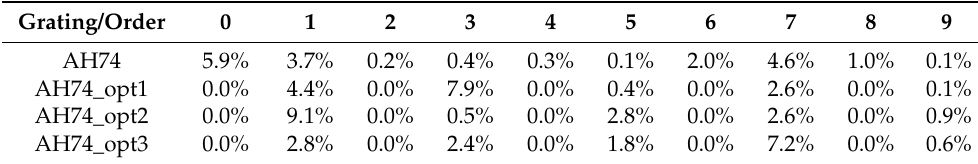
Table 5. Comparison of the efficiency of each order for AH74, AH74_opt1, AH74_opt2, AH74_opt3.